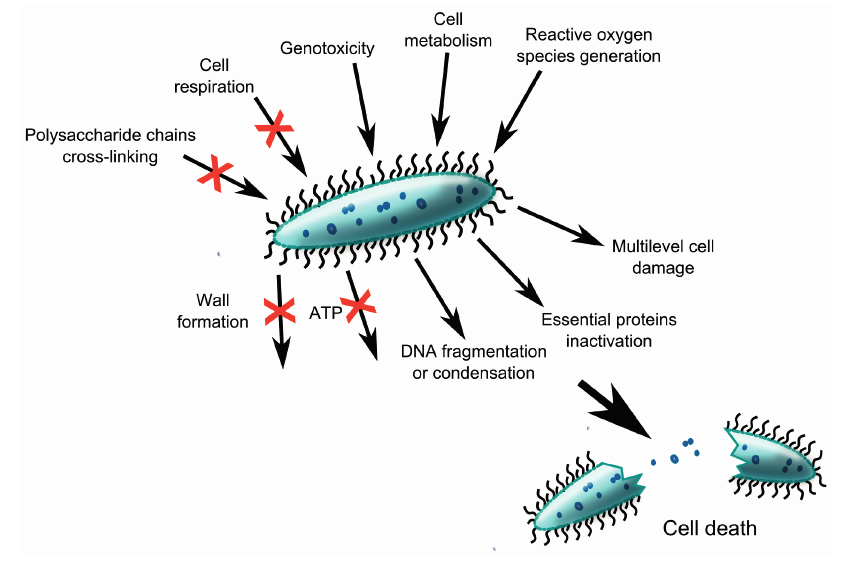
Figure 4. Potential mechanisms by which antibacterial substances kill bacteria; critical targets include bacterial cells genome, metabolic and respiration pathways, cell envelope synthesis and membrane disruptors (e.g., reactive oxygen